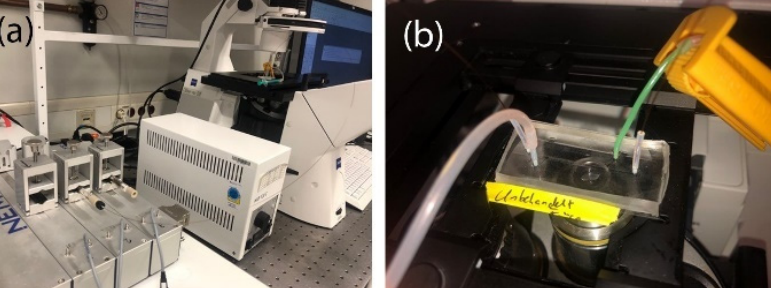
Figure 5. Set-up of the microfluidic chip analysis. ( a ) Overall set-up of the microfluidic device including the syringe pumps as liquid reservoirs and the chip on the microscope. ( b ) Chip mounted on the microscope with liquid inlet and outlet.